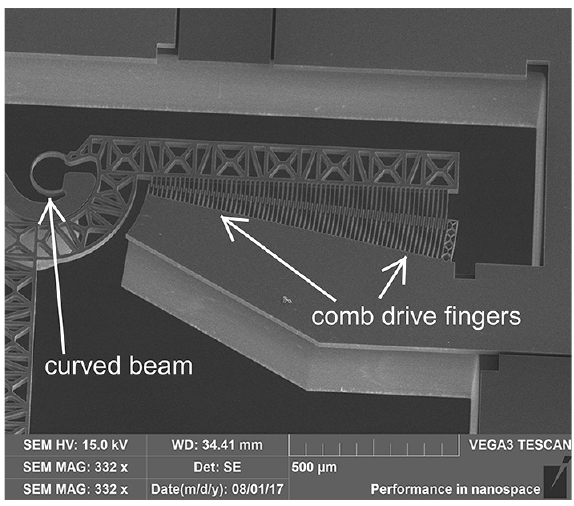
Figure 1. Curved beam adopted in CSHF hinges and comb-drive